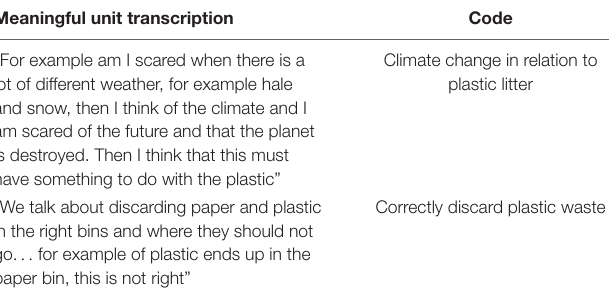
TABLE 1 | Example for meaningful unites and their codes (translated from Norwegian by IR). Meaningful unit